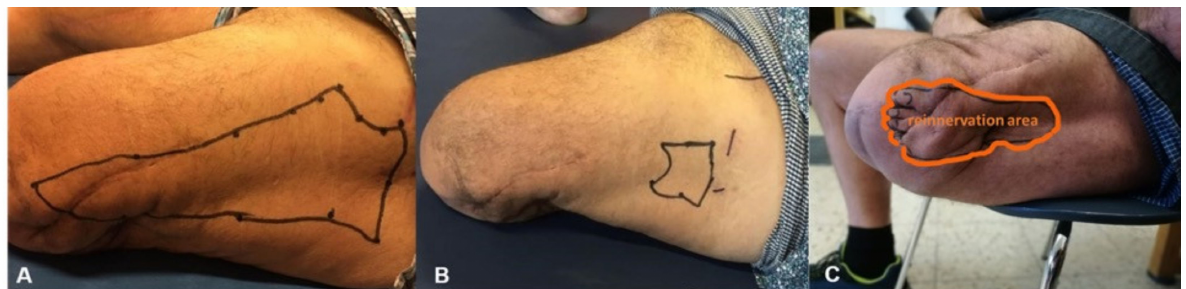
Figure 4. ( A ) Numb skin area 4 weeks after denervation; ( B ) size reduction of the numb skin area 9 months after TSR surgery; ( C ) patient’s perception of the foot within the surgically reinnervated skin area (patient 2).